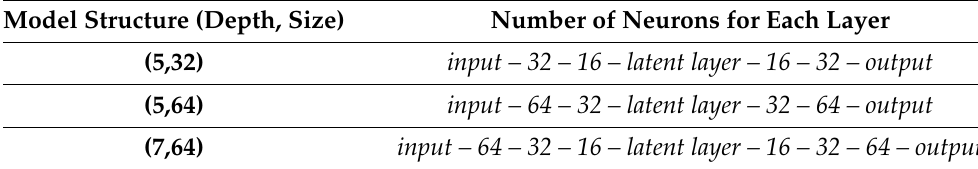
Table 4. Model Structure Configurations.